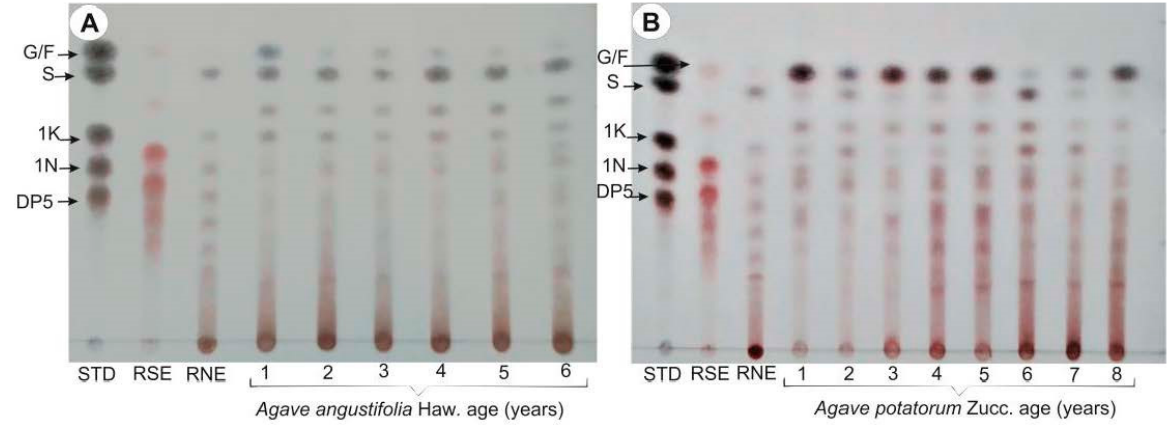
Figure 3. Thin layer chromatography (TLC) from ( A ) A. angustifolia and ( B ) A. potatorum plants at different ages. The standard nomenclature is as follows: STD, standards; RSE, raftilose; RNE, raftiline. Mobile phase: butanol/propanol/water; stationary phase: silica; derivatizing reagent: diphenylamine-aniline-phosphoric acid. See other nomenclature details in the Materials and Methods section.